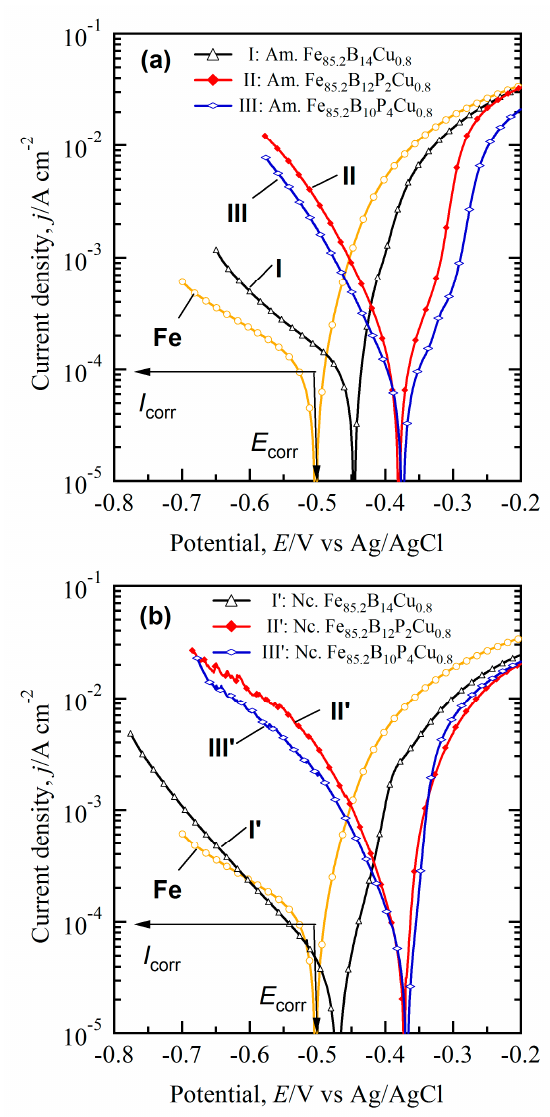
Figure 4. Potentiodynamic polarization curves of pure Fe, as-spun amorphous ( a ) and as-annealed nanocrystalline; ( b ) of Fe 85.2 B 14 Cu 0.8 (I, I ′ ), Fe 85.2 B 12 P 2 Cu 0.8 (II, II ′ ) and Fe 85.2 B 10 P 4 Cu 0.8 (III, III ′ ) ribbons in 0.1 M H 2 SO 4 solution, and Tafel slope analysis of the polarization curves of Fe plate are inserted. Am.: Amorphous; Nc.: Nanocrystalline.